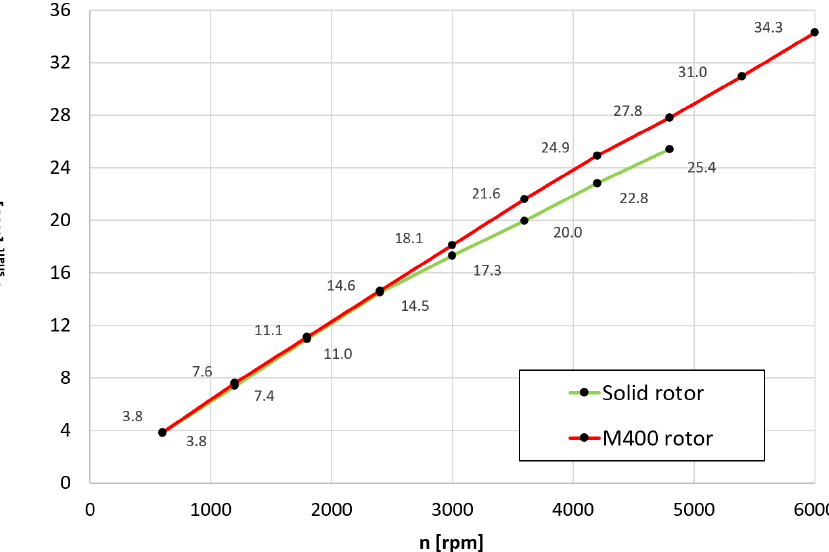
Figure 11. Comparison of the shaft power as a function of rotational speed for the rated load current I N .